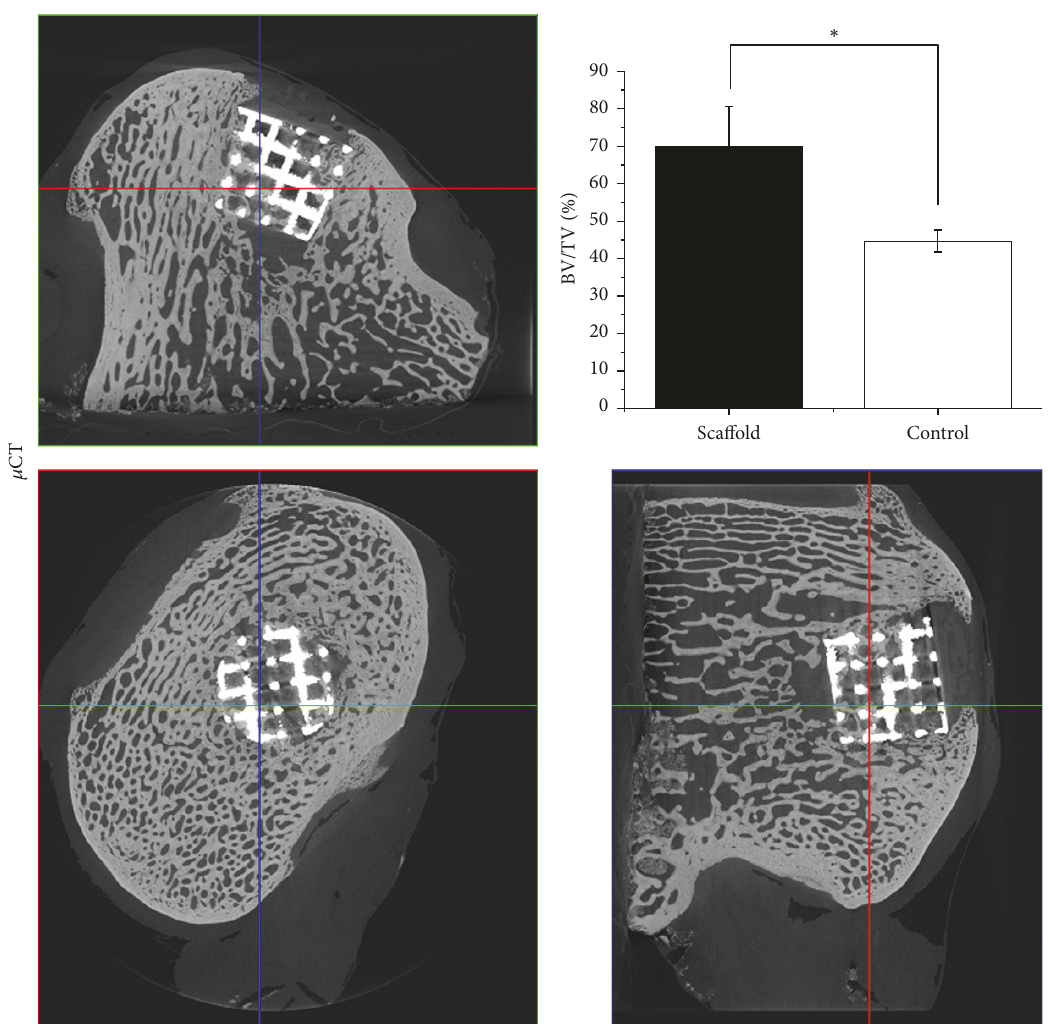
Figure 6: Bone ingrowth into Ti matrix. 𝜇 CT images show bone formation within the Ti scaffold; ∗ shows significantly higher bone volume formation in the scaffold compared to control ( 𝑝 = 0.01 ).